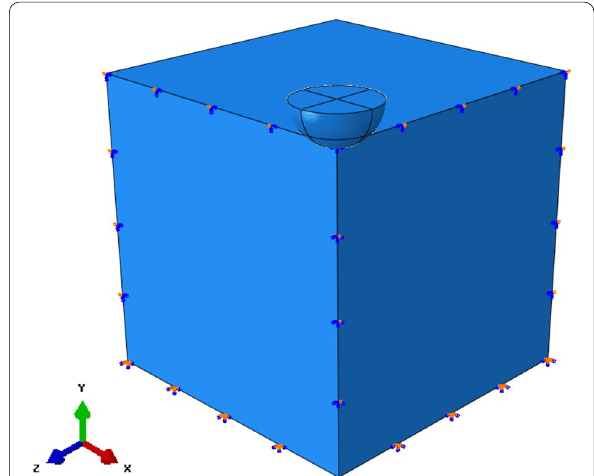
Figure 8 The boundary condition constraints